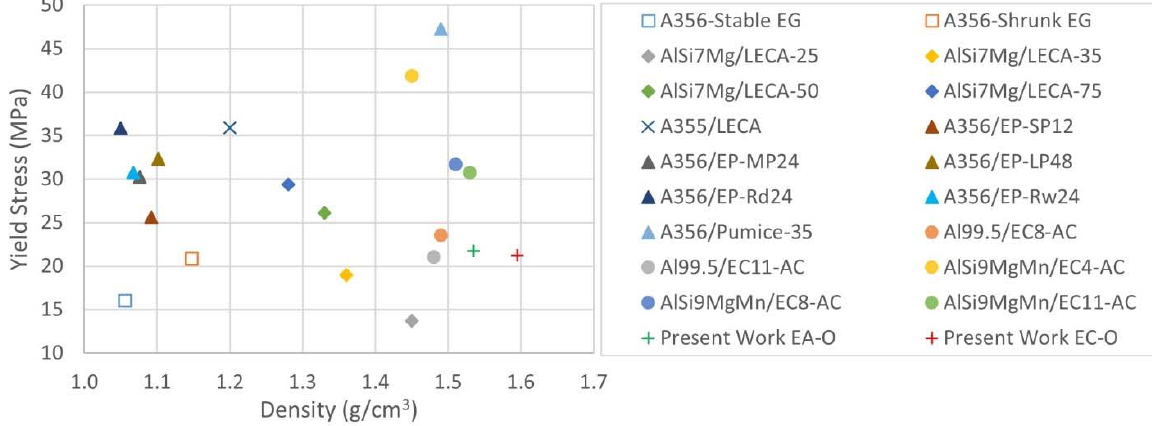
Figure 9. Comparison of average values of yield stress of ASF embedding porous fillers [11–15,20– 22].